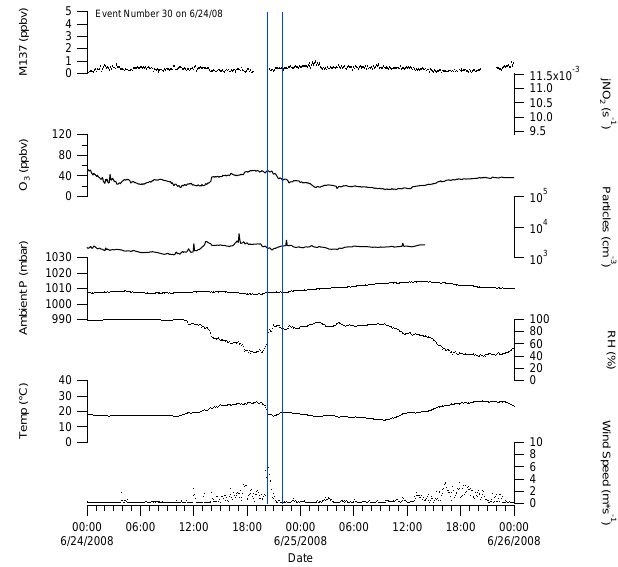
Fig. 6. An example of a Type D event, in which the storm passage had little influence on mixing ratios, from 24 June 2008. j NO 2 was not measured during this event because the instrument was not operational.